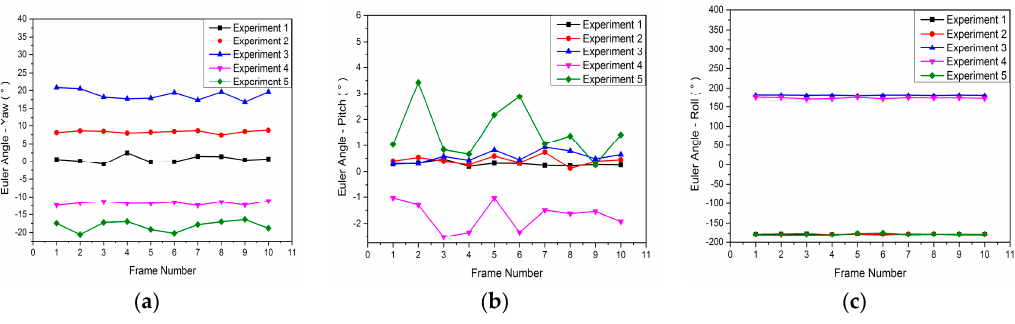
Figure 11. Euler angles for each experiment. ( a ) Yaw; ( b ) Pitch; ( c ) Roll. Table 5. The mean and the standard deviation of the Euler angles (°).